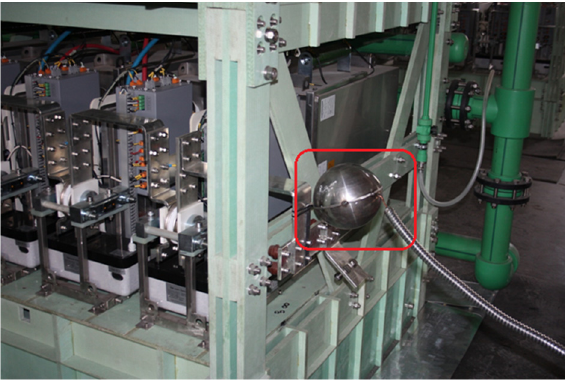
Figure 13. Metal sphere attached to the test